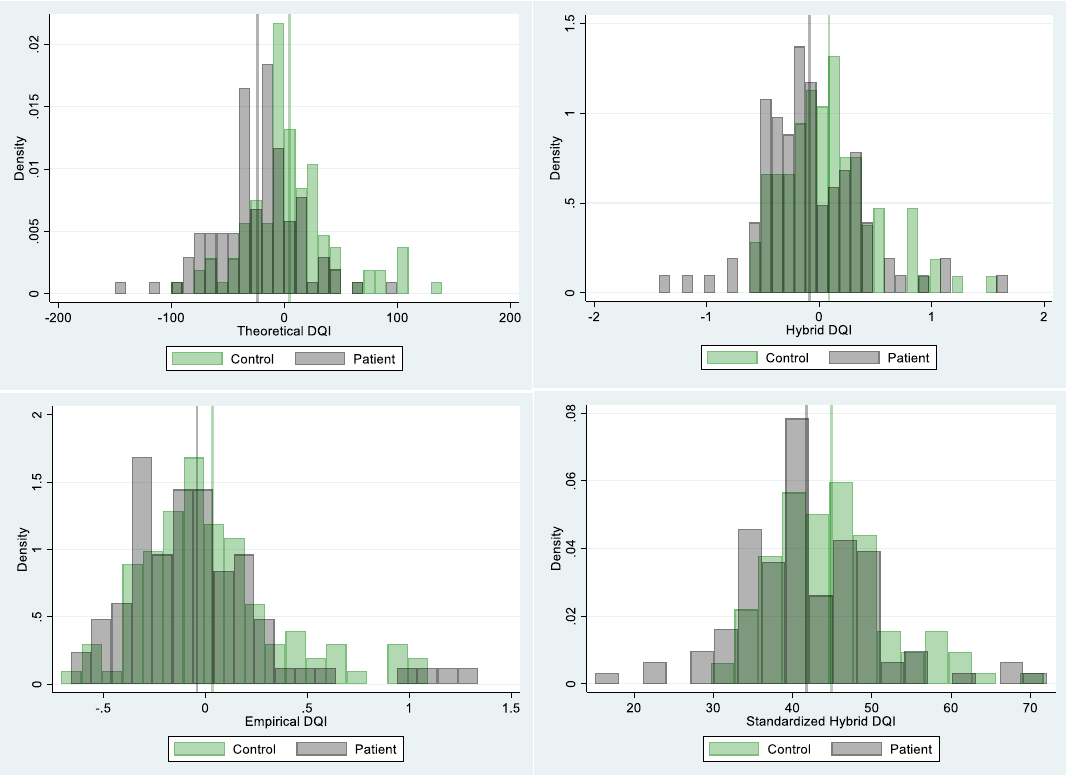
Figure 3. Histograms of the density of young adults with (patients) and without (controls) diagnosed depression by diet quality indexes calculated from food liking / disliking responses and formed by theoretically (based on dietary guidelines), empirically (based on factor analysis), and hybrid (based on conceptual and statistical approaches) approaches and the hybrid approach standardized to a 100-point scale.